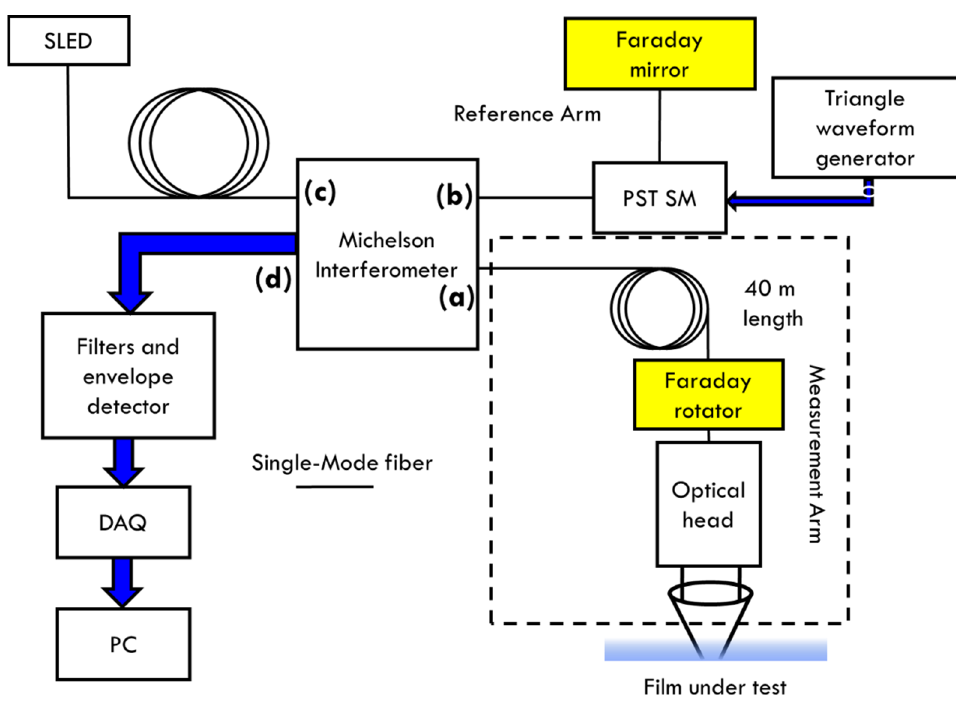
Figure 10. Final set-up of low-coherence interferometer, with Faraday mirror and rotator, to solve polarization problems. SLED is superluminescent diode; DAQ is Data Acquisition card; PST SM is Piezo Stretcher with Single Mode fiber; PC is Personal Computer. ( a ) is measurement output; ( b ) is reference output; ( c ) is SLED input; ( d ) is electrical output (same labels of Figures 3 and 4).